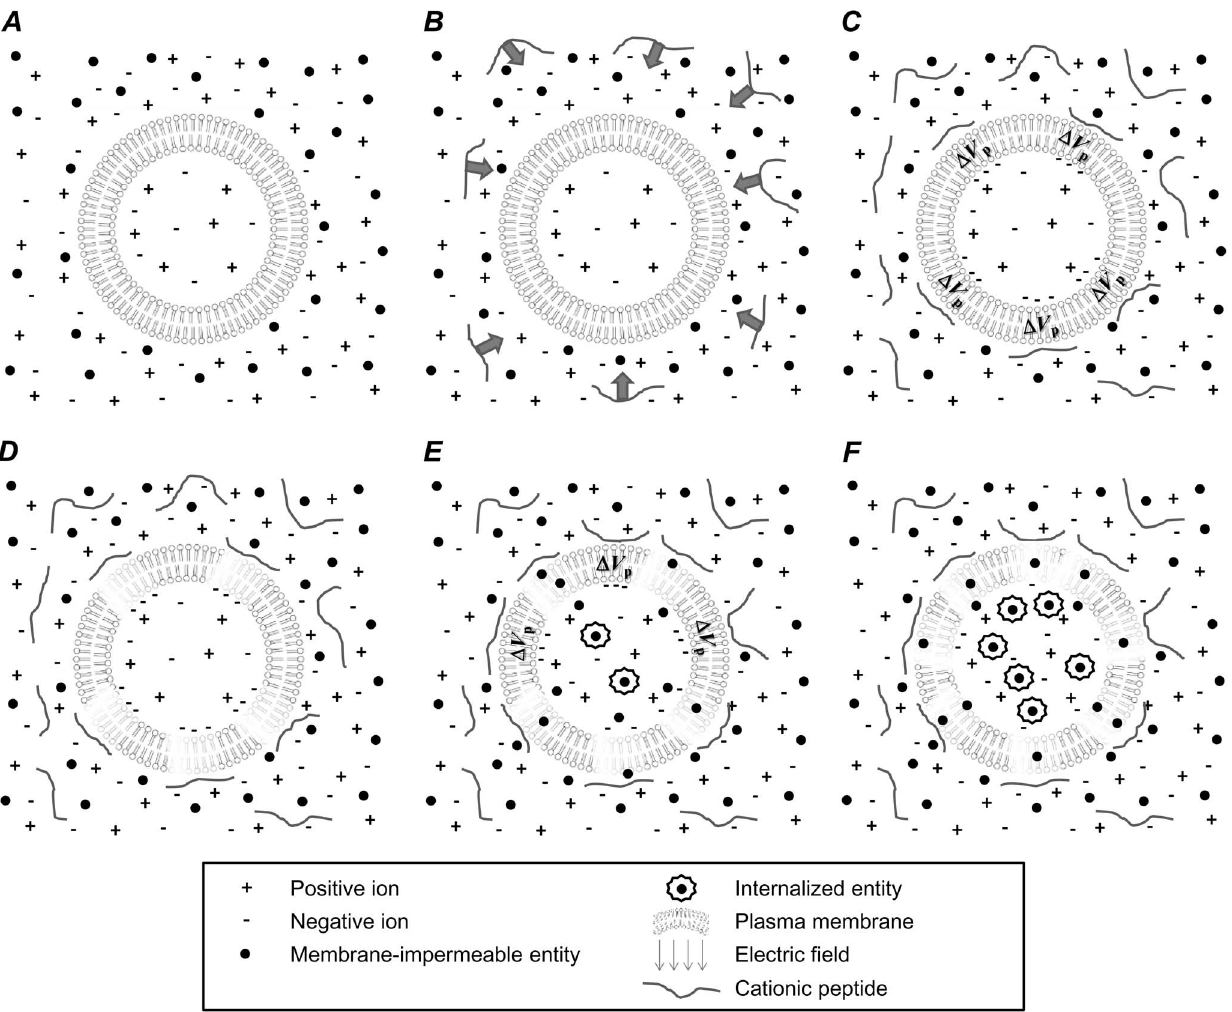
Figure 1. Cationic peptide exposure can eventually lead to prolonged membrane disruption through electrostatic peptide- membrane interaction. A cell rests in an ionic media with membrane-impermeable entities ( A ) and cationic peptide is introduced into that media ( B ). Cationic peptides will electrostatically collect about the negatively charged plasma membrane ( C ) and increase the electrostatic potential across the membrane in the vicinity of the peptide ( V p ). D – E : These transmembrane voltages may be sufficient for electroporation and disrupt the membrane in a manner leading to internalization of normally membrane-impermeable entities. E – F : Particularly at higher cationic peptide concentrations, the media serves as a reservoir for additional peptides to co-localize with the plasma membrane, causing prolonged